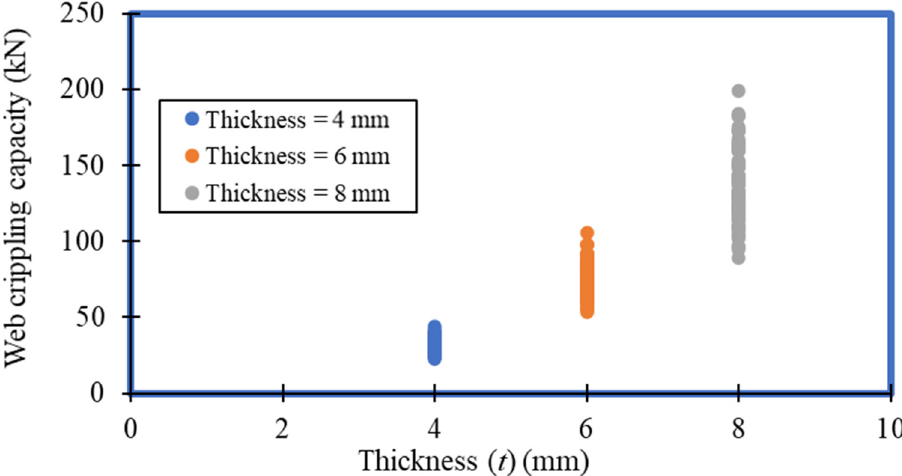
Figure 17. Effect of thickness ( t ) on the web crippling